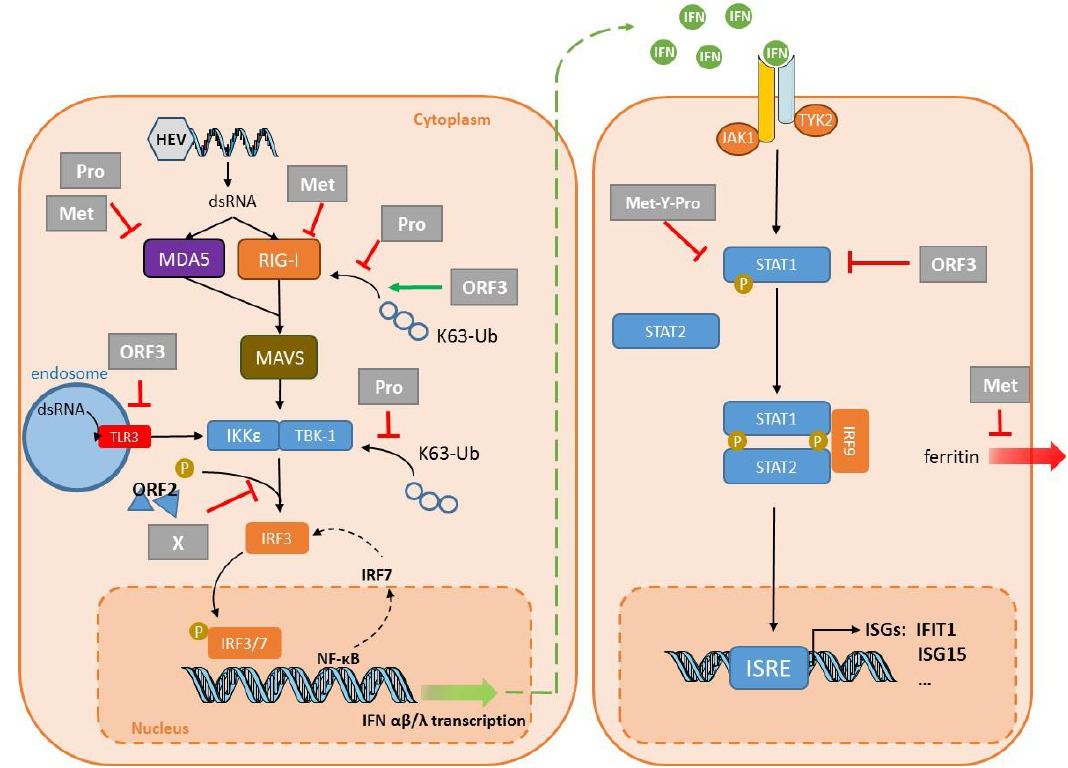
Figure 2. Interplay between innate immunity and hepatitis E virus (HEV). Double-stranded (ds) HEV RNA is detected in the cytoplasm by retinoic acid-inducible gene I (RIG-I) and melanoma differentiation-associated protein 5 (MDA5), leading to type I and type III interferon (IFN) production. TLR3 detects HEV RNA in the endosomal compartment. The protease domain (Pro) of the ORF1 protein inhibits signaling via RIG-I and prevents IFN induction by removing ubiquitin from RIG-I and TANK binding kinase 1 (TBK-1). Pro and Met can also interfere with the MDA5 signaling pathway. The methyltransferase domain (Met) also acts on RIG-I to reduce IFN production, and interferes with ferritin secretion to decrease the inflammatory response. The X domain (X) and the capsid protein ORF2 inhibit the phosphorylation (P) of IFN regulatory protein 3 (IRF3). Conversely, the ORF3 protein stimulates the direct production of type I IFN via RIG-I, while ORF3 interferes with TLR3 synthesis. ORF3 and part of ORF1 (methyltransferase + Y domain + Protease: Met-Y-Pro) also bind to STAT1 to restrict its phosphorylation and the activation of the downstream cascade, thus inhibiting IFN-stimulated gene (ISG) expression, including that of “interferon-induced protein with tetratricopeptide repeats 1” (IFIT1) and ISG15. Abbreviations include IKKε: IκB-kinase-epsilon; IRF3, 7 or 9: IFN regulatory protein 3, 7 or 9; ISRE: interferon-stimulated response element; MAVS: mitochondrial antiviral-signaling protein; STAT1 or 2: signal transducer and activator of transcription 1 or 2; and Ub: ubiquitin.